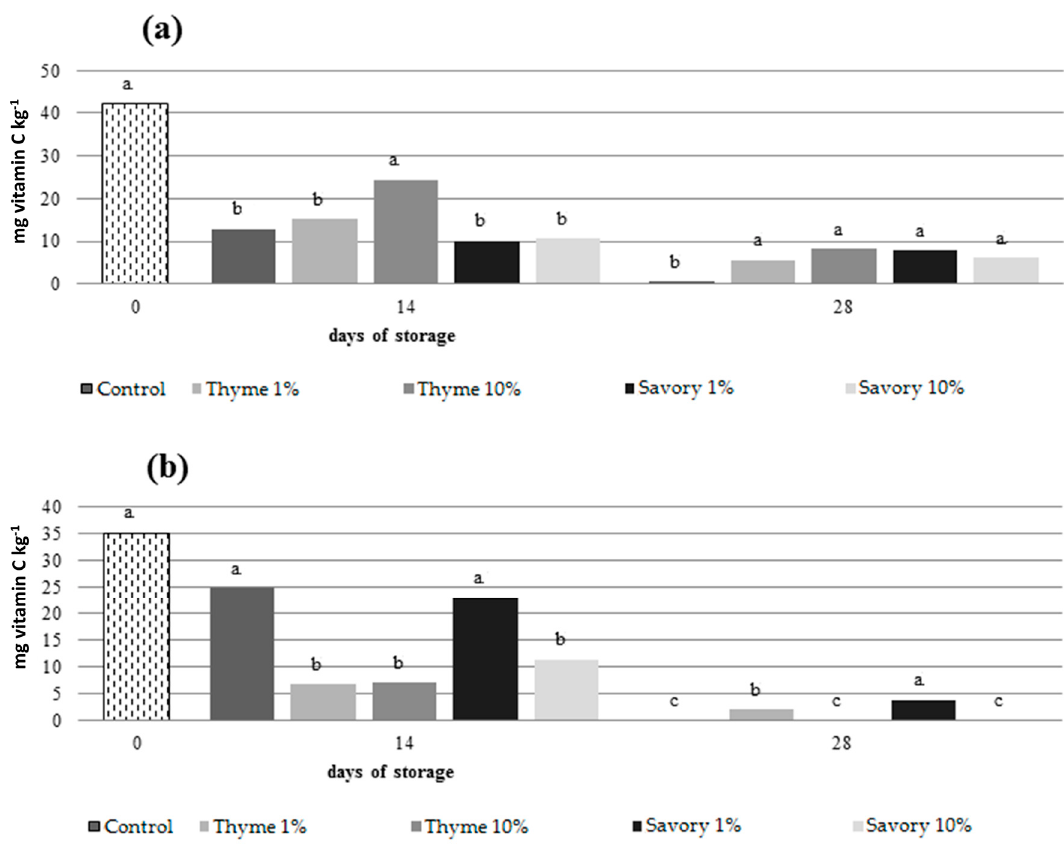
Figure 4. Total content of vitamin C (ascorbic acid and dehydroascorbic acid) in nectarines ‘Sweet Red’ ( a ) and peaches ‘Vista Rich’ ( b ) after 0, 14 and 28 days of cold storage. Mean values at the same time followed by the same letter are not significantly different by Tukey’s Test at p ≤ 0.05.